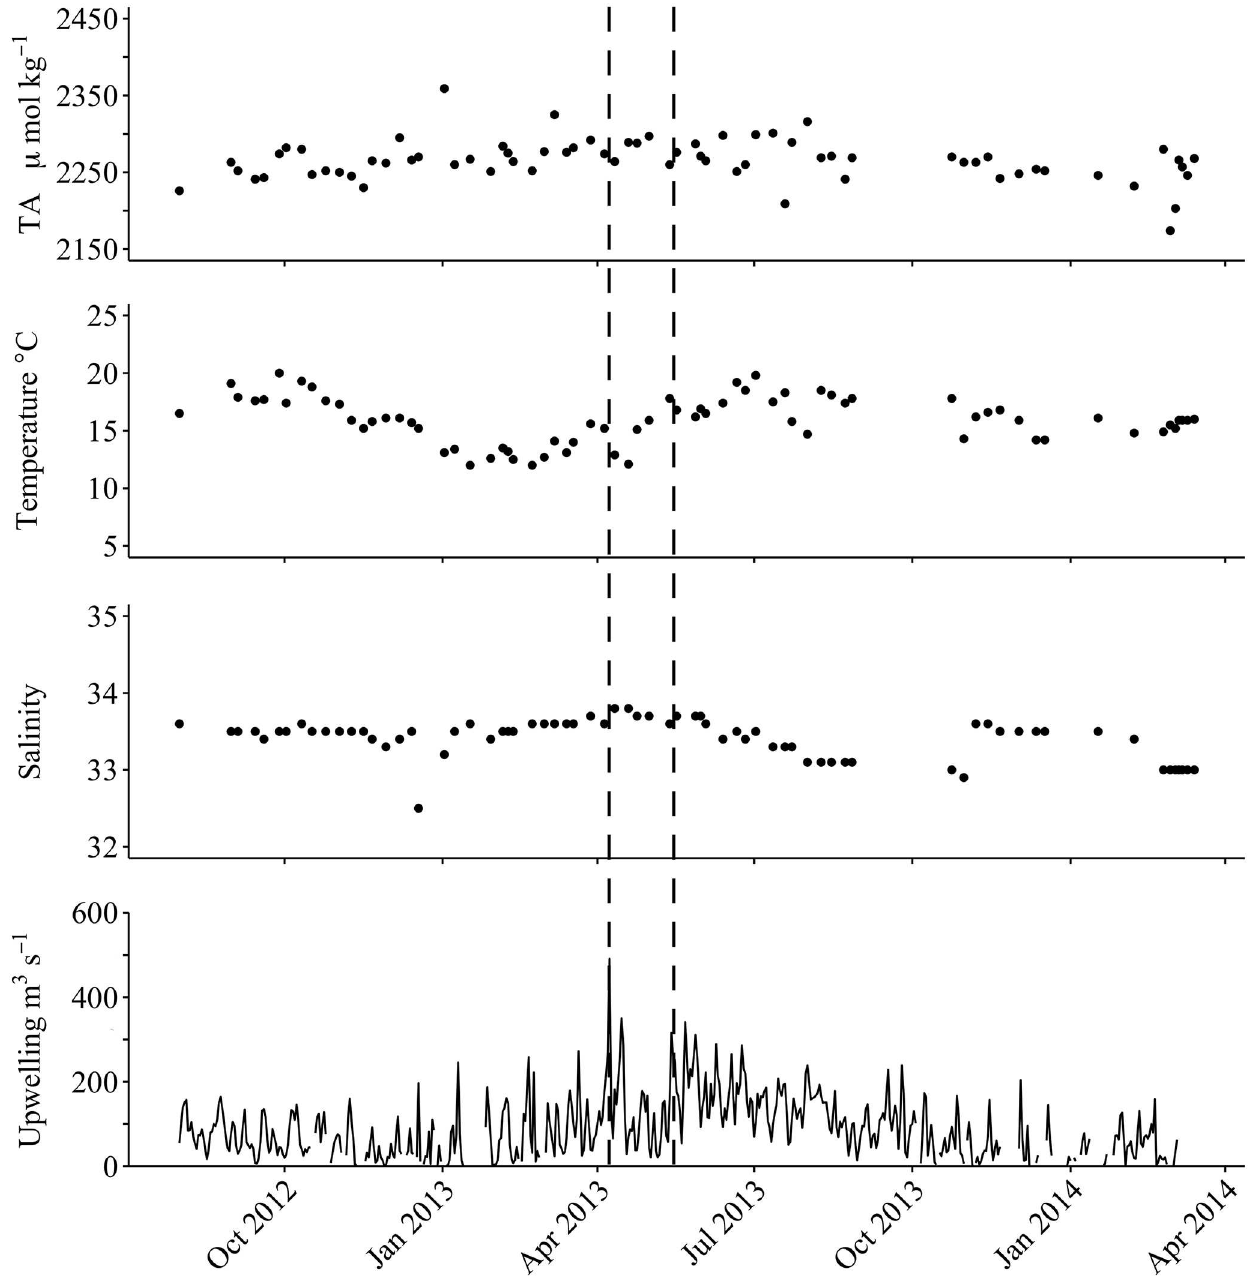
Fig 3. Upwelling as a driver of total alkalinity at Stearns Wharf. Total alkalinity(top) shows little connectionto upwellingevents, though there are occasionalspikes in the upwelling index (dotted lines) that co-occur with changesin temperature and